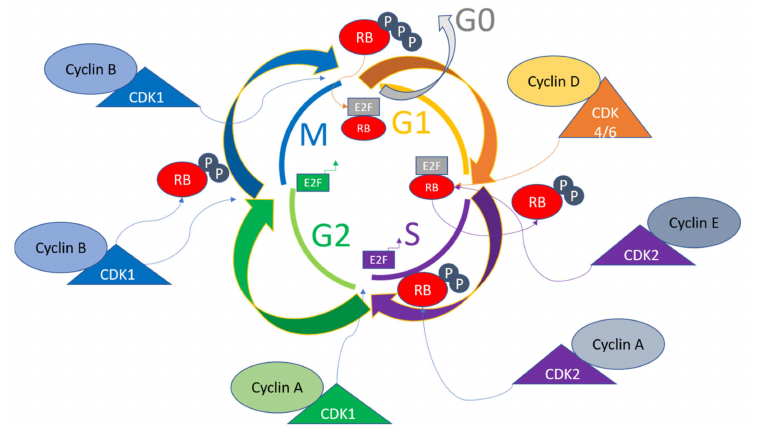
Figure 1. General pathway of cell cycle regulation. Various Cyclins activate different CDKs se- quentially to progress the cell cycle and determine the fate of the cells. The CDKs in turn act to phosphorylate various substrates for transitioning the cell cycle phases. For example, RB is one of the major regulators of the cell cycle, and is the target of CDK4/6, CDK2, and CDK1, and together with activated E2F and its target genes, leads to the transition of cell cycle